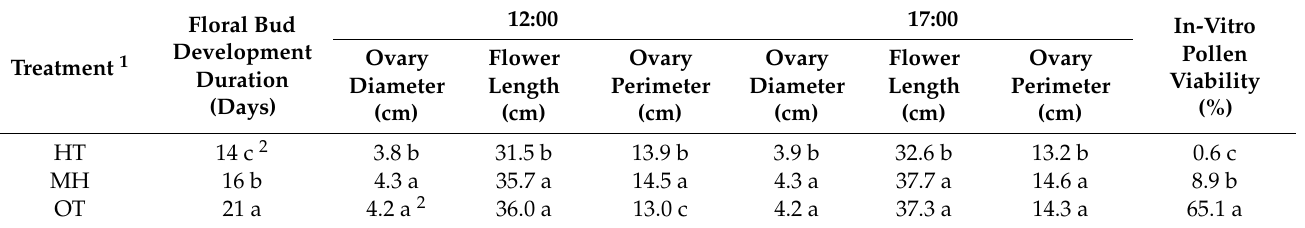
Table 1. Comparison of flower characteristics and pollen viability at bloom day in “Da Hong”